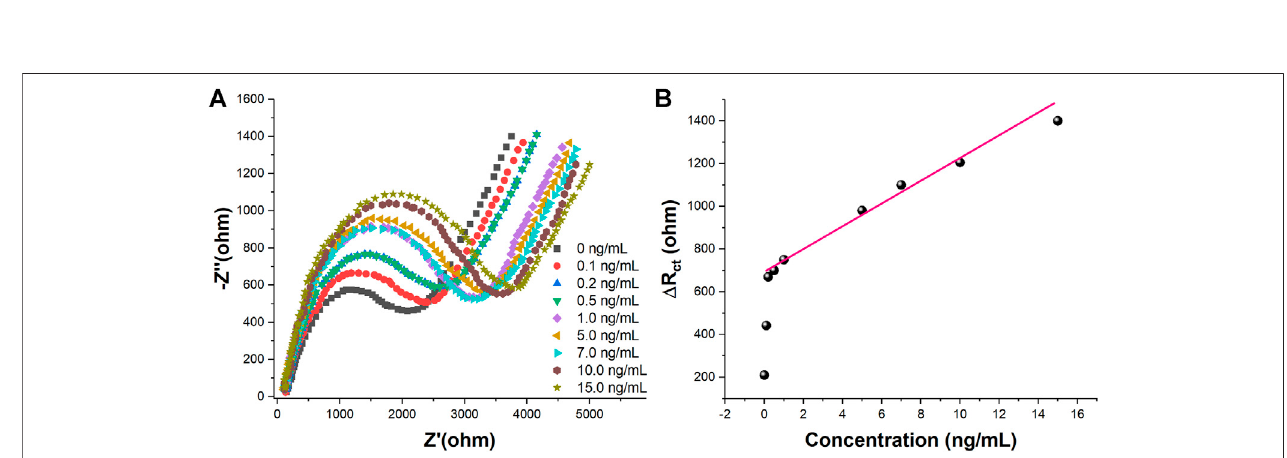
FIGURE7 | (A) EIS in 5 mM [Fe(CN) 6 ] 3 − /4 – 0.1 M PBS(pH7.0) − 1 M KCl oftheproposed aptasensor towards 0, 0.1, 0.2, 0.5, 1.0, 5.0, 7.0, 10.0, and 15.0 ng/mlof CEA (B)Plots of